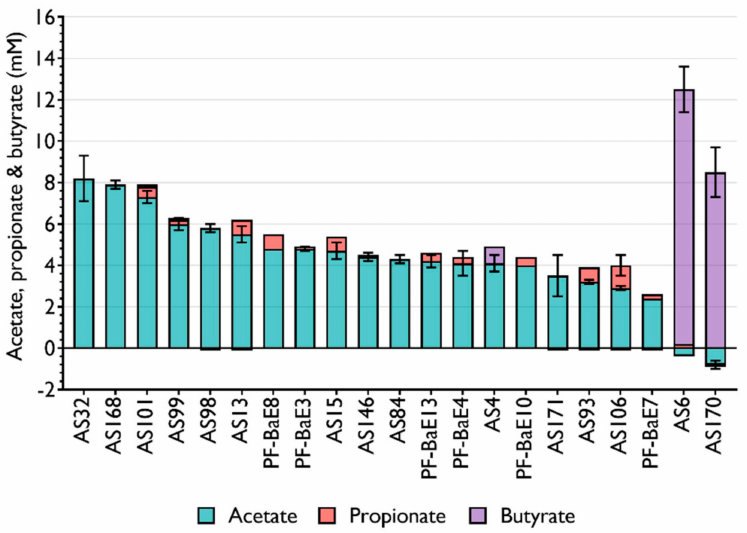
Figure 2. Production of acetate, butyrate, and propionate in the supernatant of bacterial cultures reported in mM for 1 OD 600nm unit of bacterial culture. Data are expressed as the means of 2 independent experiments ±